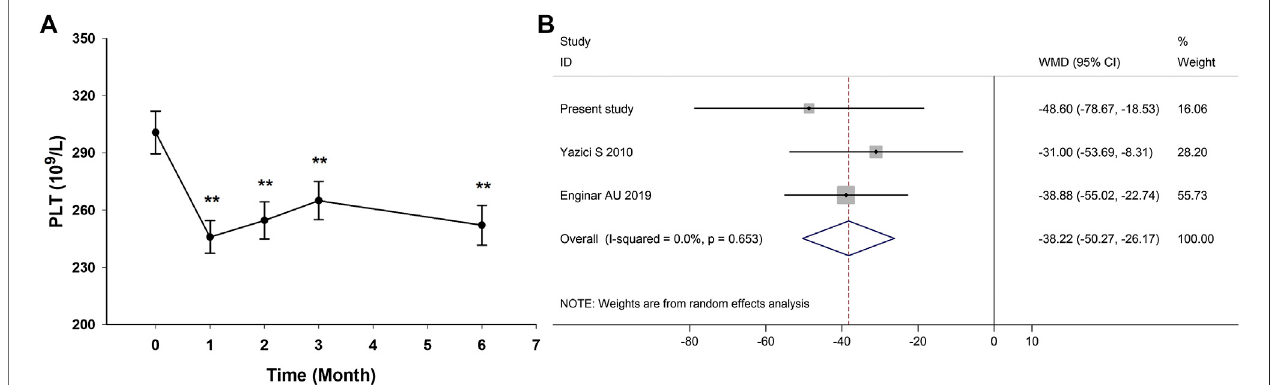
FIGURE4 | Impact of anti-TNF- α therapy on platelet count in AS patients. (Anti-TNF- α therapy could reduceplatelet count in AS patients at the fi rst month and the effect was maintained through the treatment duration (A) . Meta-analysis con fi rmed the signi fi cantly reduced platelet count in AS patients after anti-TNF- α therapy (B) . WMD, weighted mean difference; 95% CI, 95% con fi dence interval.)